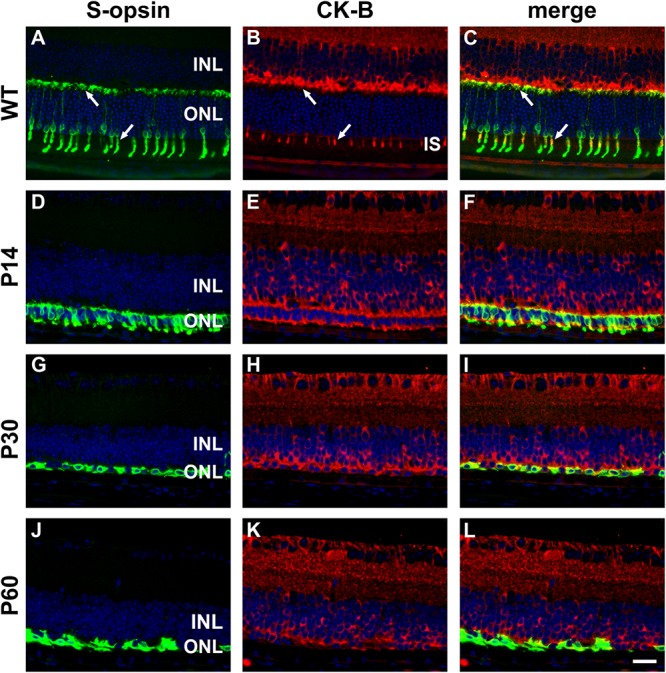
Representative double labeling immunofluorescence images of cytosolic creatine kinase (CK-B) with S-opsin in wild-type (WT) mouse retina and in Rd1 mouse retinas from postnatal day (P) 14 to P60. In WT retinas (A–C), CK-B colocalizes with S-opsin in cone inner segments (arrows), and in axonal terminals in the outer plexiform layer (arrows). At P14, CK-B colocalizes with S-opsin in shrunken inner segments and axonal terminals, with weak CK-B labeling of somas (D–F). From P30 to P60, the ONL comprises a single layer of surviving cones largely devoid of segments. CK-B colocalizes with S-opsin in cone somas and axonal terminals (G–L). At all time points, CK-B is also expressed by inner retinal neurons and Müller cells. All images were captured from the inferior retina, which comprises primarily S-cones. INL, inner nuclear layer; IS, inner segments; ONL, outer nuclear layer. Scale bar: 20 μm.